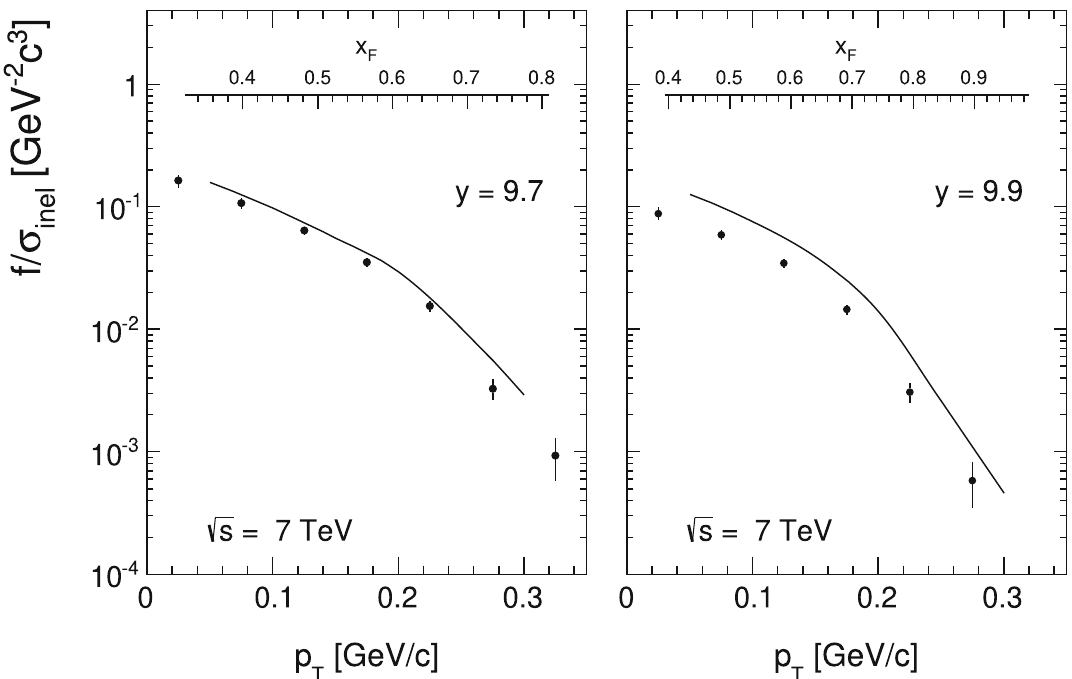
√ s = 7 TeV (data points from LHCf) compared to